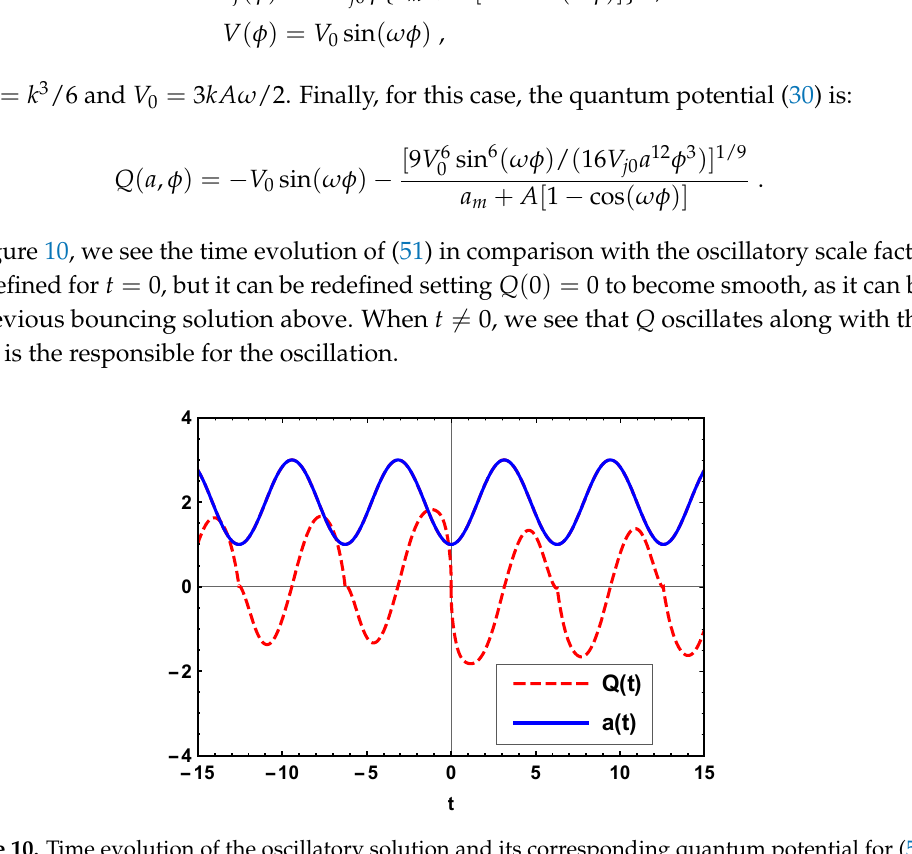
Figure 10. Time evolution of the oscillatory solution and its corresponding quantum potential for (50), with k = A = ω = a m =